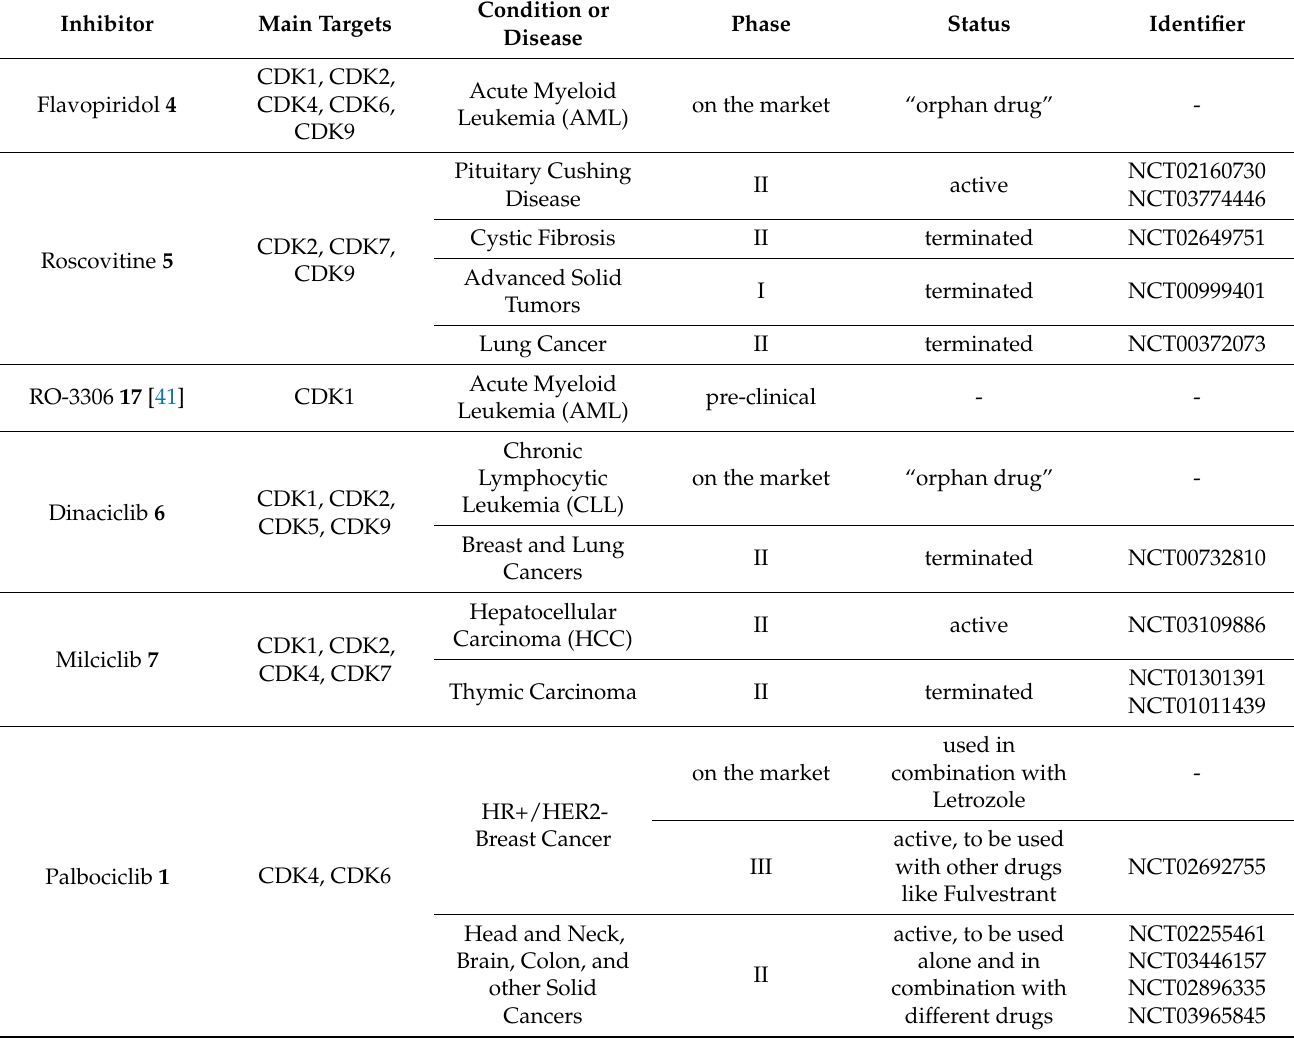
Table 2. Type I CDK inhibitors at different phases of clinical and pre-clinical studies. Trial information obtained from ClinicalTrials.gov as of January